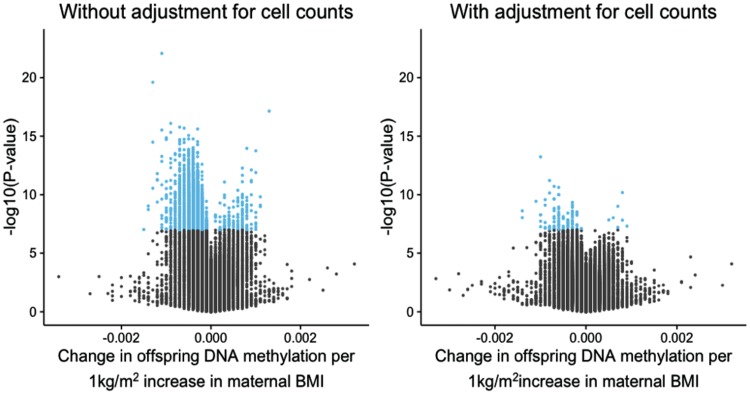
Volcano plots to illustrate the large increase in P-values after adjusting for estimated cell counts. Methylation sites that reached the Bonferroni threshold for multiple testing (1.06 × 10−7) are highlighted in blue.